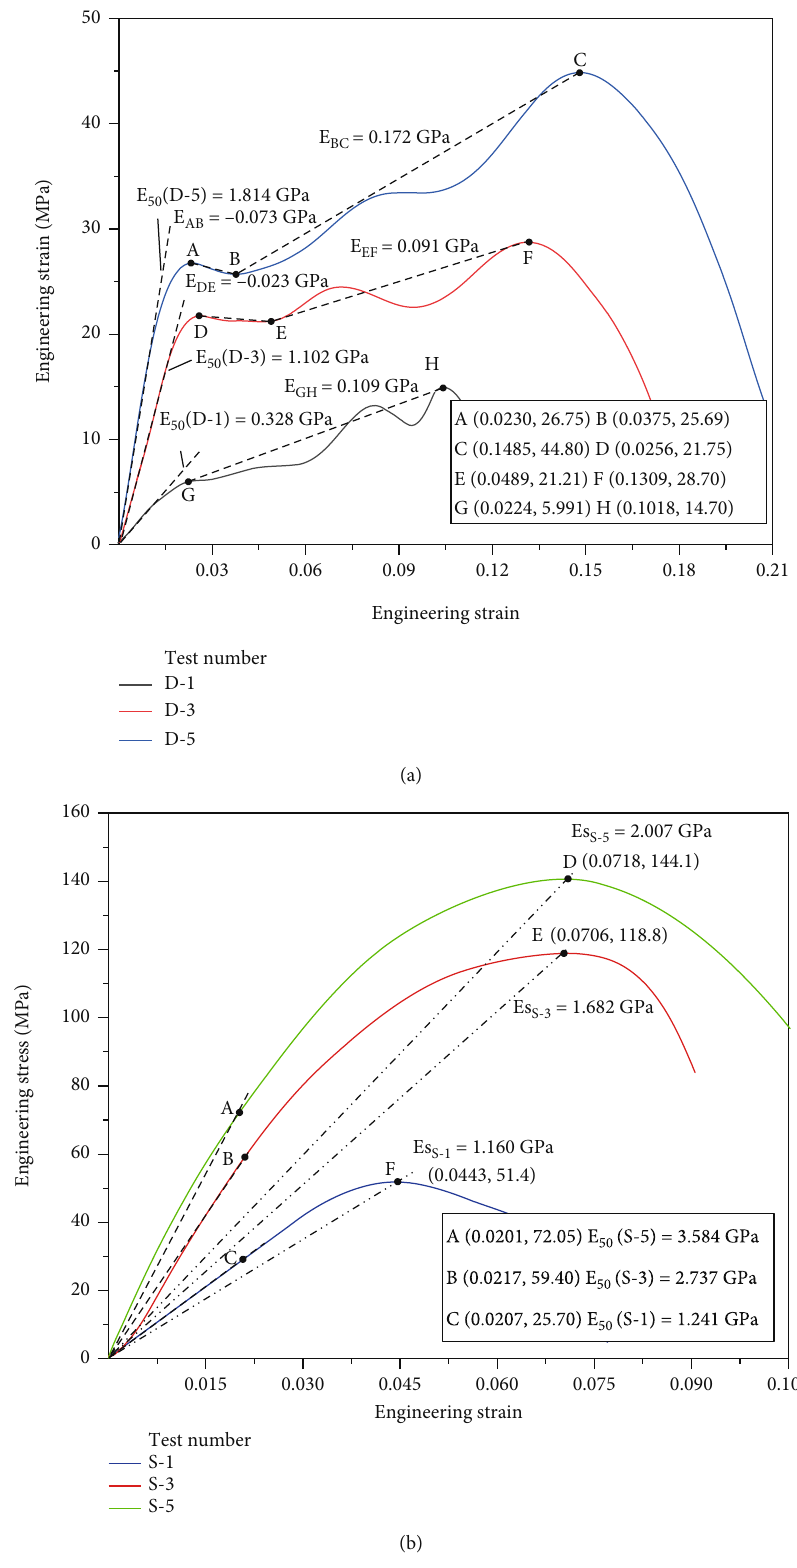
Figure 6: Dynamic stress-strain curves of specimens. (a) D-1, D-3, and D-5. (b) S-1, S-3, and